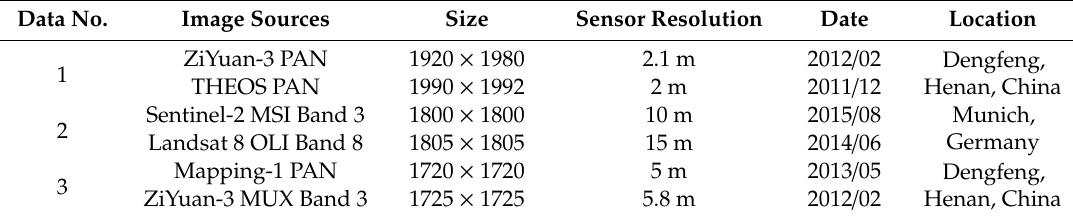
Table 1. Basic information about the images used in the tie point matching experiment. Data